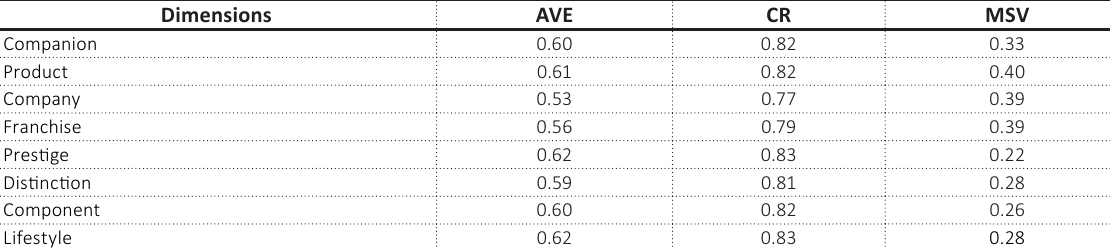
Table 5. AVE, CR, and MSV for brand extension